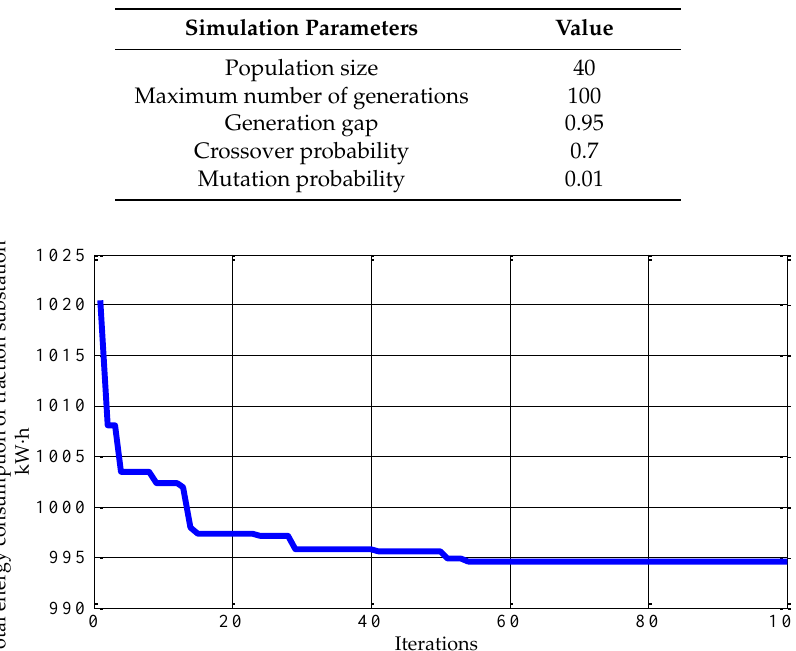
Table 4. Simulation parameters.